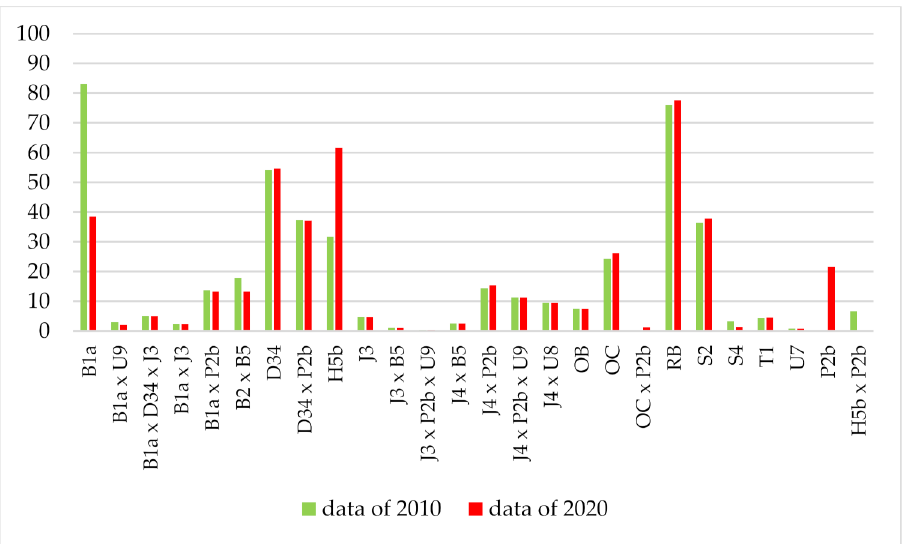
Figure 3. Habitat cover (hectares) of Dejt á r area in 2010 and